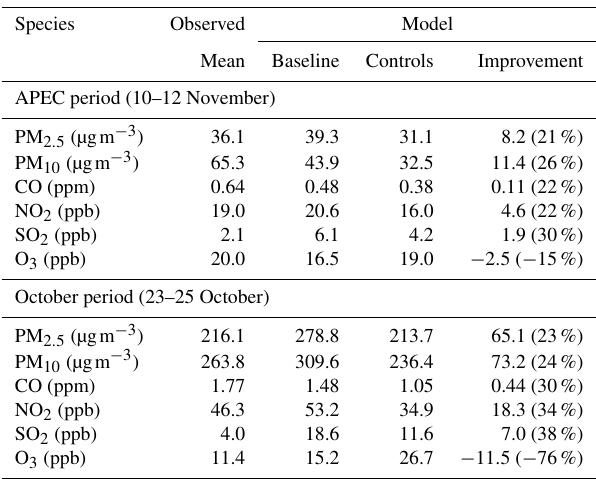
Table 7. Influence of emission controls averaged over Beijing air quality stations in October and